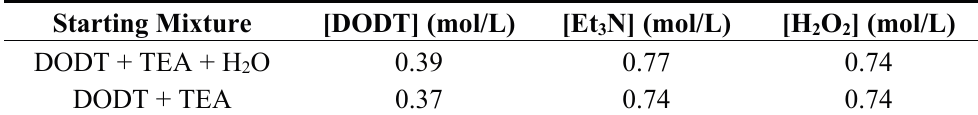
Table 2. Concentration of reagents in two DODT